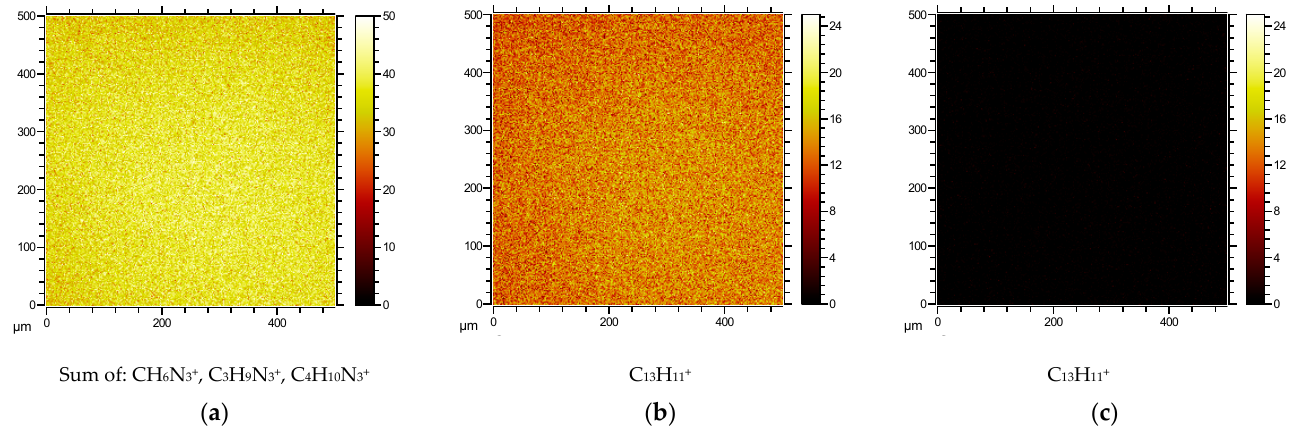
Figure 5. Typical ToF-SIMS images of an Au–SAM surface coated with azidopeptide-containing biphenylalanine, 2a : ( a ) ion intensities for CH 6 N 3+ , C 3 H 9 N 3+ , and C 4 H 10 N 3+ of arginine; ( b ) ion intensity of biphenylalanine-ion C 13 H 11+ ; ( c ) ion intensity image of control Au–SAM surface observed at the biphenylalanine-specific ion C 13 H 11+ .